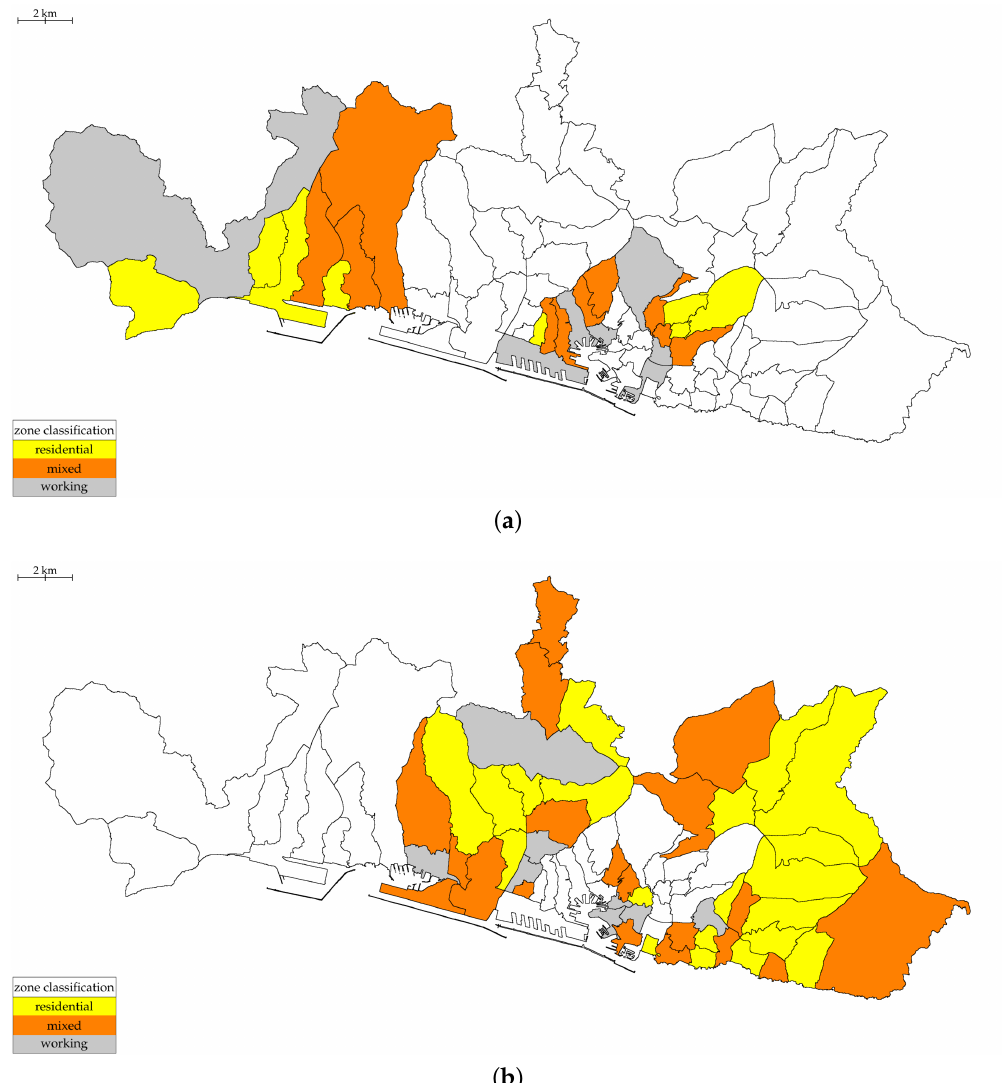
Figure 7. OD zones belonging to ( a ) the training set and ( b ) the test set. Furthermore, according to the characteristics of the region around Genoa, which is a port city on the Ligurian Sea and is mostly surrounded by forestland, the set of nonurban land-cover classes in the considered case study is ¯ Ψ “ t vegetation, water body u . The training map for “vegetation”, “water body”, and “urban cover” is shown in Figure 8a. It has been used within the proposed techniques to train random forest for estimating P p y i | r i q ( y i P ¯ Ψ ) and P p Ψ | r i q , i.e., the posteriors of “vegetated”, “water body”, and of the urban cover as a whole, given the remote sensing features. In particular, the multispectral channels of the input Sentinel-2 image have been used as remote sensing features in the application of the proposed fusion techniques. Similarly, Figure 8b shows the test map used in the quantitative assessment of the proposed algorithms. Since both methods assign each pixel a class label in the complete set of classes Ω “ Ψ Y ¯ Ψ , both urban land-use and nonurban land-cover classes are present in this test